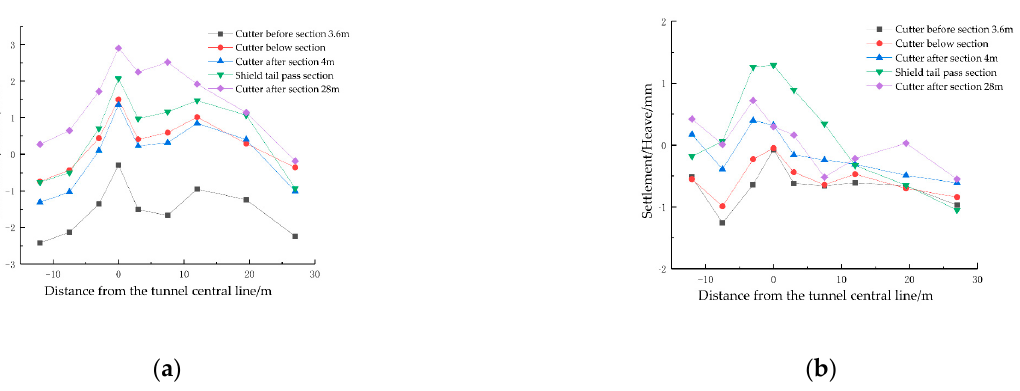
Figure 8. Surface deformation : ( a ) section of DBC-L-101; ( b ) section of